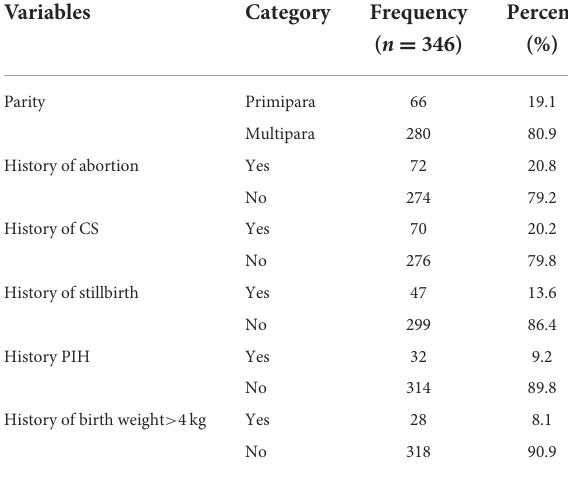
TABLE 3 Current obstetrics characteristics of diabetic mothers delivered at the Tikur Ambessa Specialized Hospital in Addis Ababa, Ethiopia,